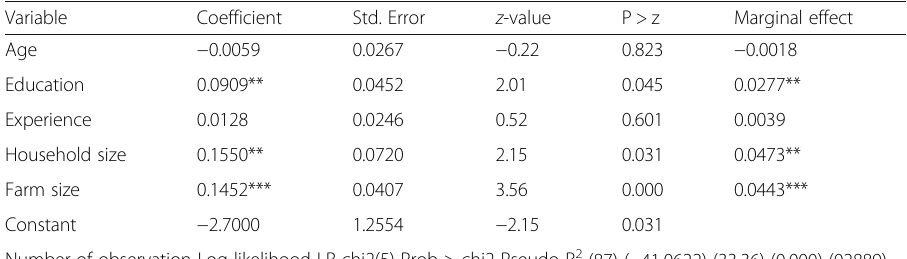
Table 4 Results of Probit Regression